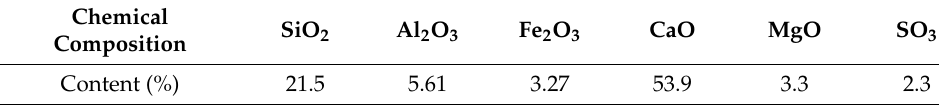
Table 1. Chemical composition of cementitious material (% by mass).